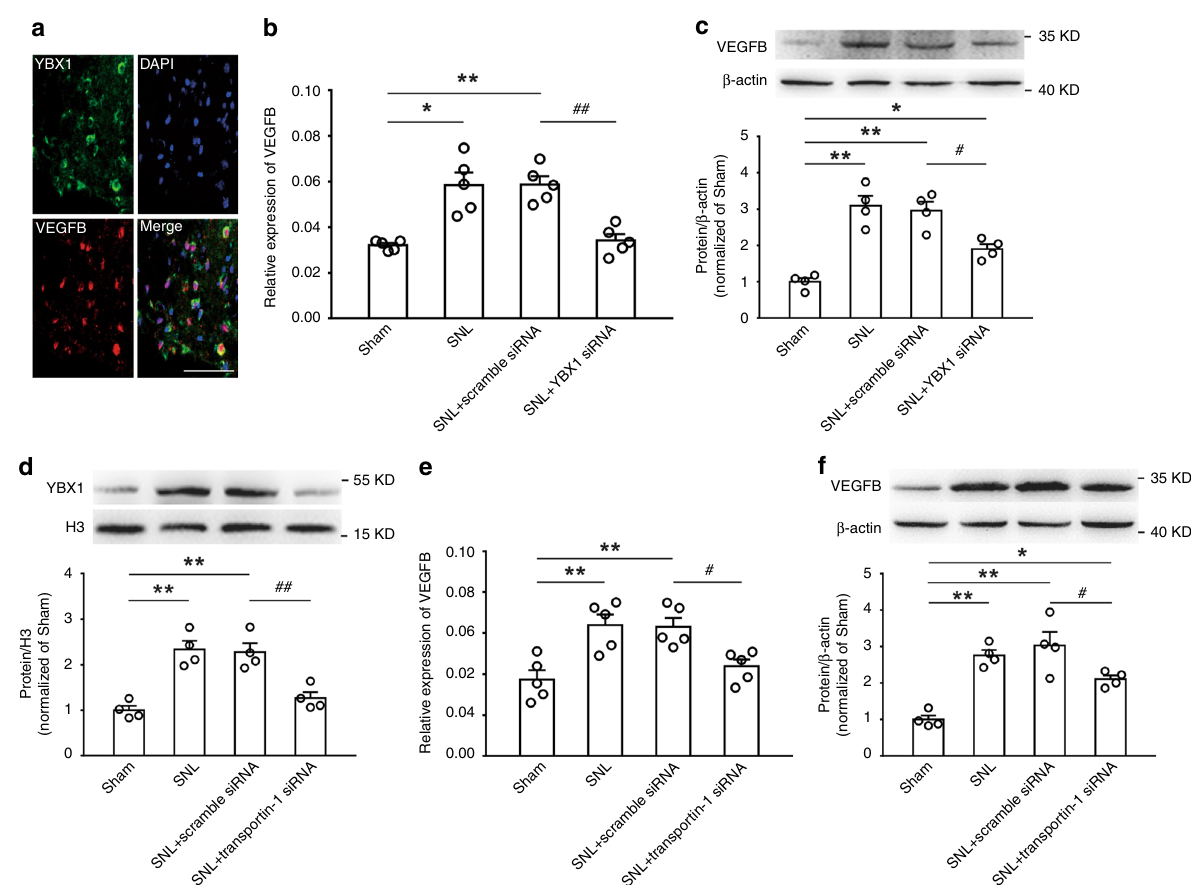
Fig. 7 Increased YBX1 in the nucleus contributes to VEGFB expression. a Representative image labeled for YBX1, VEGFB, and DAPI. Scale bar, 50 μ m ( n = 3). b Continuous intrathecal administration of YBX1 siRNA prevented the upregulation of VEGFB mRNA induced by SNL ( * P < 0.05, ** P < 0.01 vs. sham group, ## P < 0.01 vs. corresponding scramble group, two-tailed one-way ANOVA, n = 5). c YBX1 siRNA (i.t.) attenuated the VEGFB protein upregulation on day 14 after SNL ( * P < 0.05, ** P < 0.01 vs. sham group, # P < 0.05 vs. corresponding scramble group, two-tailed one-way ANOVA, n = 4). d